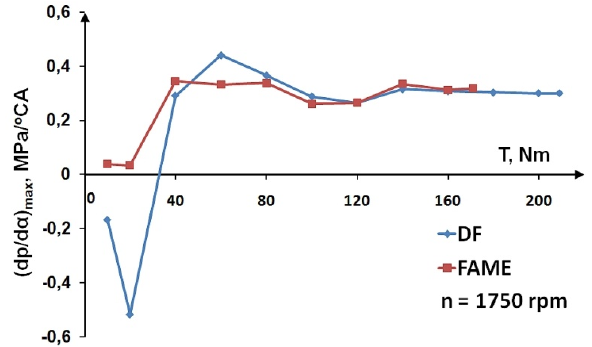
Figure 5: Comparison of the maximum pressure increase rate in the cylinder ( dp / dα ) max of the Fiat 1.3 MultiJet engine